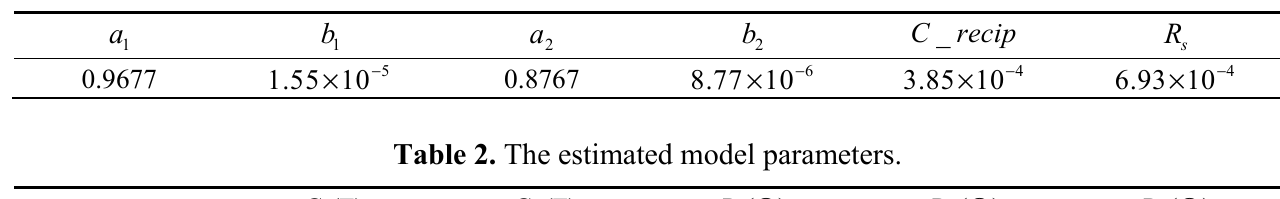
Table 1. The estimation results of the extended Kalman filter.